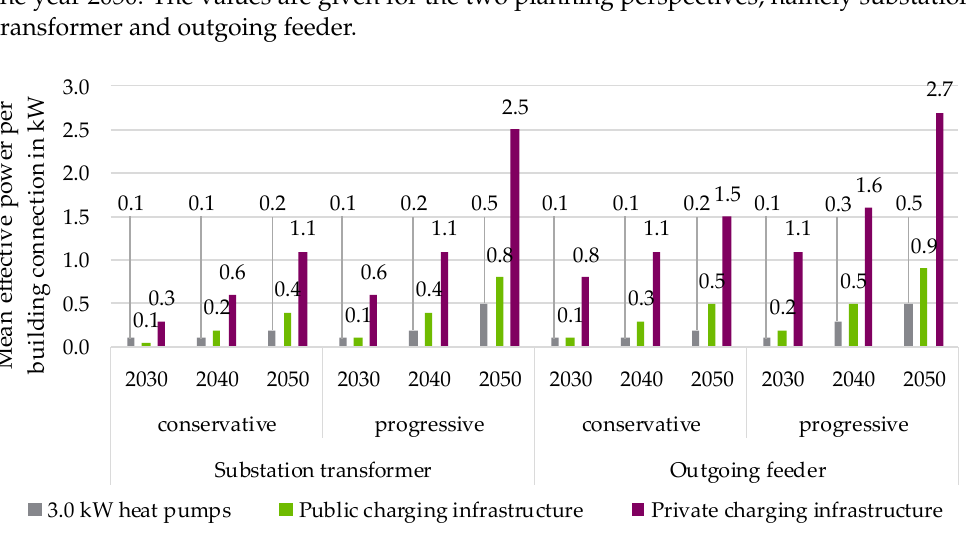
Figure 12. Mean effective power per building connection for dimensioning the substation transformer and outgoing feeders for private and public charging infrastructure and 3.0 kW heat pumps.